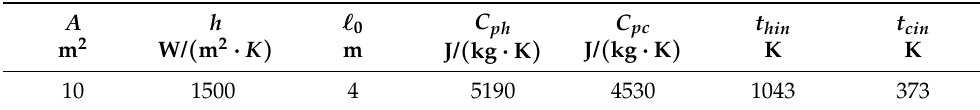
Table 3. Parameters of the helical steam generator of HTGR.